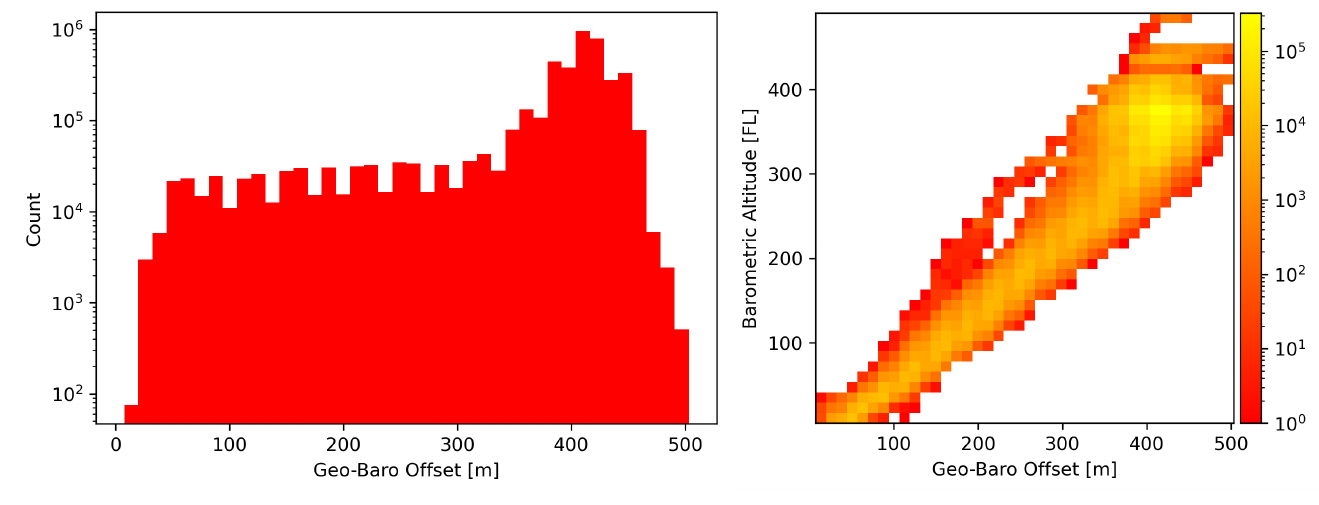
Figure 1. Geometric/Barometric Altitude Offsets. ( a ) Altitude Error Distribution. ( b ) Altitude Error Distribution over Barometric Flight